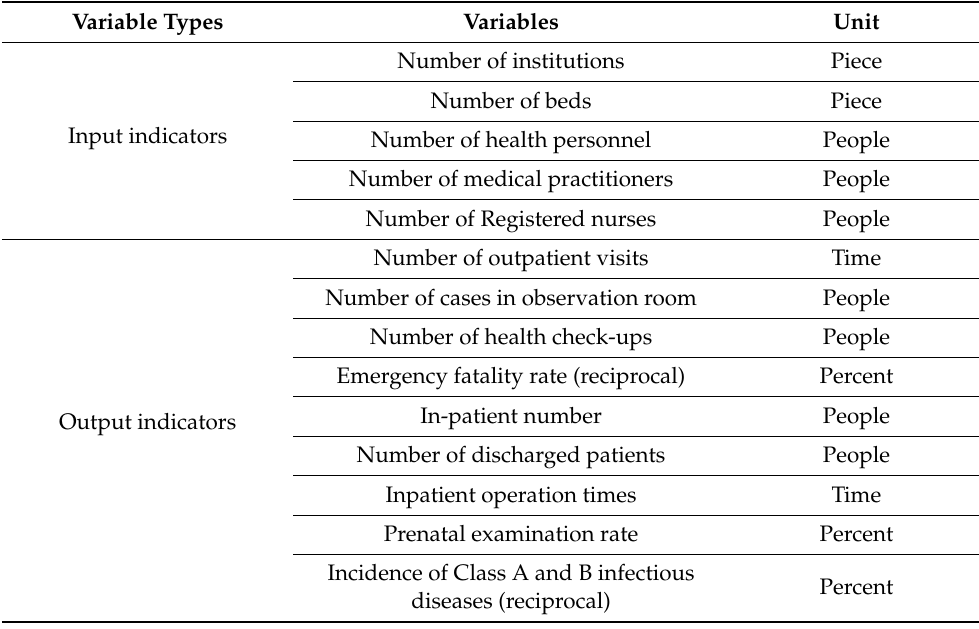
Table 1. Fiscal health expenditure efficiency index system.